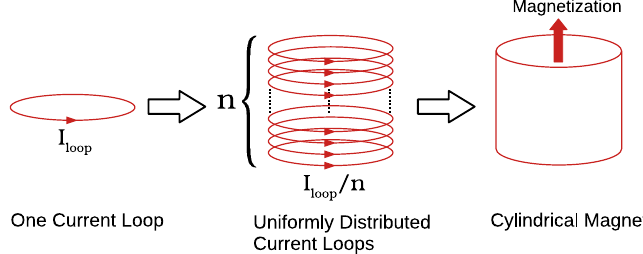
Figure 9. Simplified process of modeling a 3D cylindrical magnet by superposition of uniformly distributed current carrying